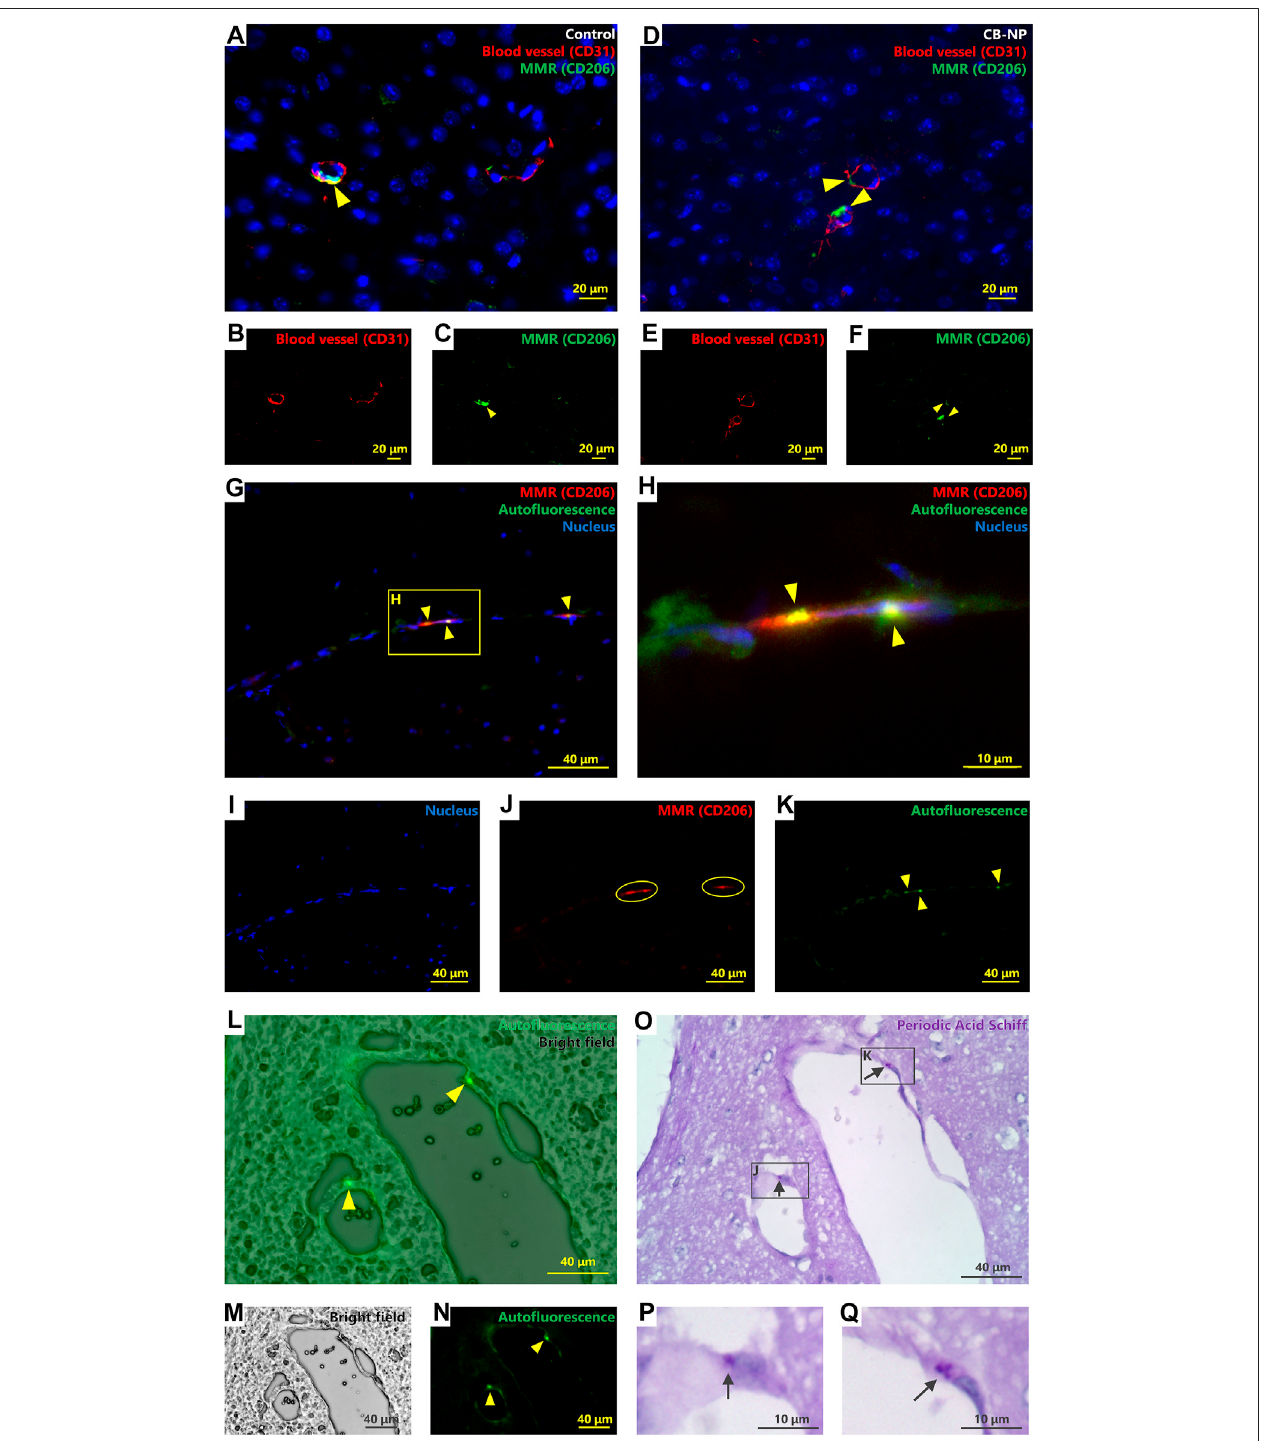
FIGURE1| Identi fi cationandcharacterizationofbrainperivascularmacrophages(PVMs).Auto fl uorescence,macrophagemannosereceptor(MMR)expression,andPeriodic acid-Schiff(PAS)stainabilitywereevaluatedtodetectandidentifyPVMsusingbrainsectionsfromthecontrolgroup. (A – F) Immuno fl uorescenceofmacrophagemannosereceptor (MMR) and CD31, a blood vessel marker. (A,D) are merged pictures of B and C, and E and F, respectively. Arrowheads indicate MMR-positive cells. MMR-positive cells were observedonlyaroundthebloodvesselsinthecerebralcortex.Activatedmicroglia(MMR-positivemicroglia)werenotdetectedineithercontrol (A – C) orCB-NPgroups (D – F) (G – K) Immuno fl uorescence of MMR and auto fl uorescence. H shows an enlarged view of (G) . (G) is a merged picture of (I – K) . Arrowheads indicate auto fl uorescence granules. CirclesindicatecellsexpressingtheMMR.Auto fl uorescencewasdetectedinMMR-positivecells. (L-Q) Localizationofauto fl uorescencegranulesandPAS-positivegranules. (L) isa mergedpictureof (M,N) .Arrowheadsindicateauto fl uorescenceofPVMgranules.Brainsectionin (O) wasserialsectionof (L – N) . (P,Q) showenlargedviewsofapartof (O) .Arrows indicate PAS-positive granules. The localization of auto fl uorescence and PAS-positive granules was consistent.